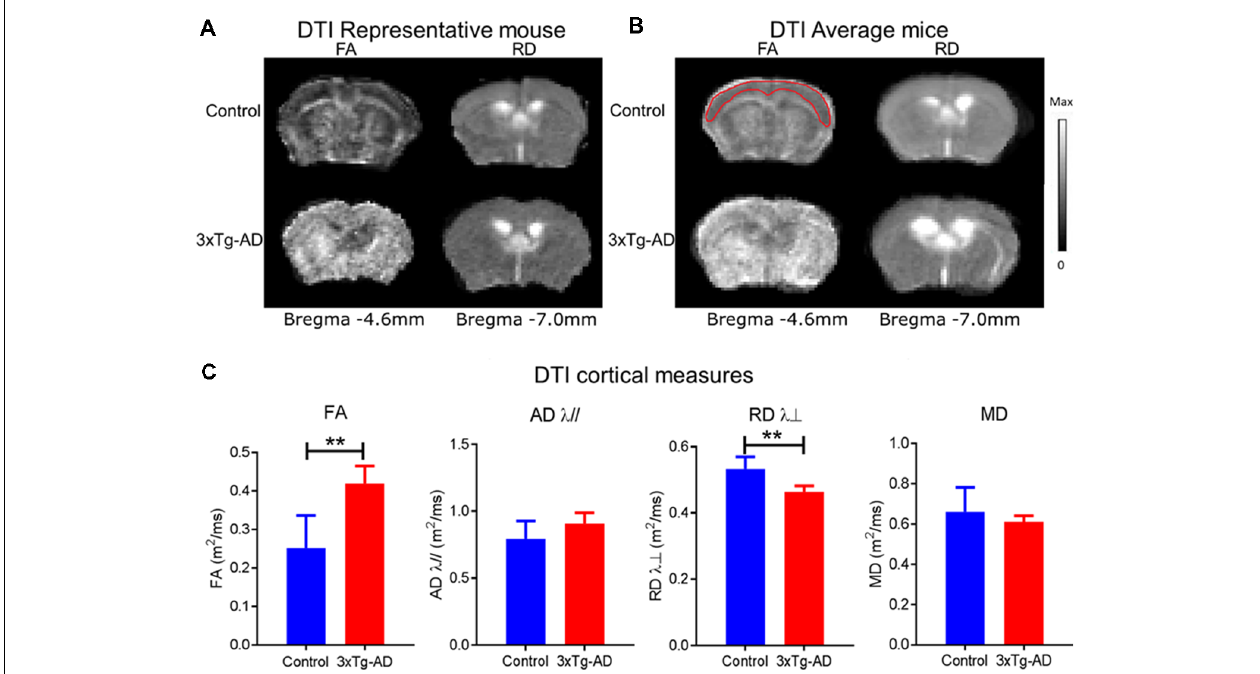
FIGURE 3 | FA and RD alterations in 3xTg-Alzheimer’s disease (AD) and control mice. Diffusion tensors are FA, MD, (RD λ ⊥ ), (AD λ //). The grayscale bar indicates the range of values displayed in the DTI parametric maps. The maximum values for FA, λ //, λ ⊥ and MD maps are 1.0, 3.0, 2.0, and 3.0 m 2 /ms, respectively. (A) Representative mouse FA maps (first column of brains from left) and RD λ ⊥ maps (second column of brains from left) from individual 3xTg-AD and control mice. (B) Average group maps for 3xTg-AD and control values for FA maps (third column of brains from left) and RD λ ⊥ maps (fourth column of brains from left). Note the red outline for FA control in the average group panel represents the approximate ROI for measures. (C) Bar plots of DTI cortical measures: FA, MD, RD λ ⊥ , and AD λ // for control (blue) and 3xTg-AD (red) with standard deviation. The asterisk ∗∗ indicates significant P < 0.01.